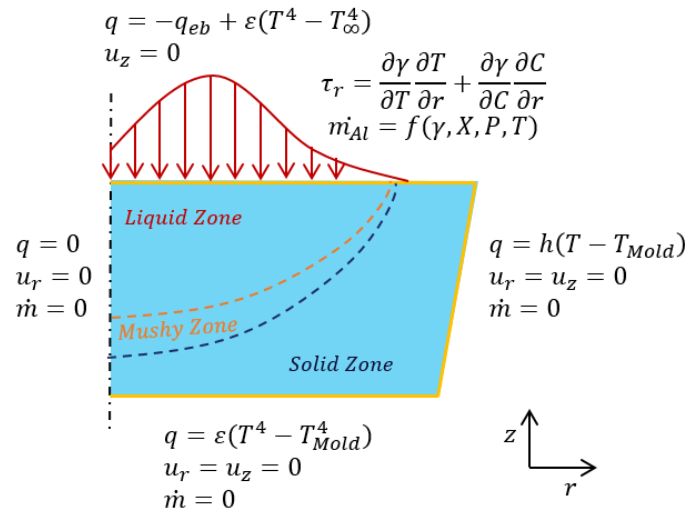
Figure 5. Summary of validation model boundary conditions.